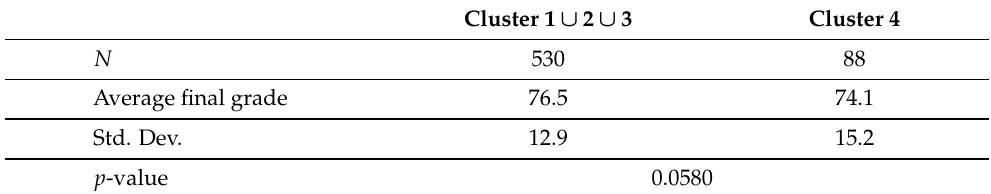
Table 4. p -values for one-tail t -tests’ comparisons among clusters’ average grades (MI